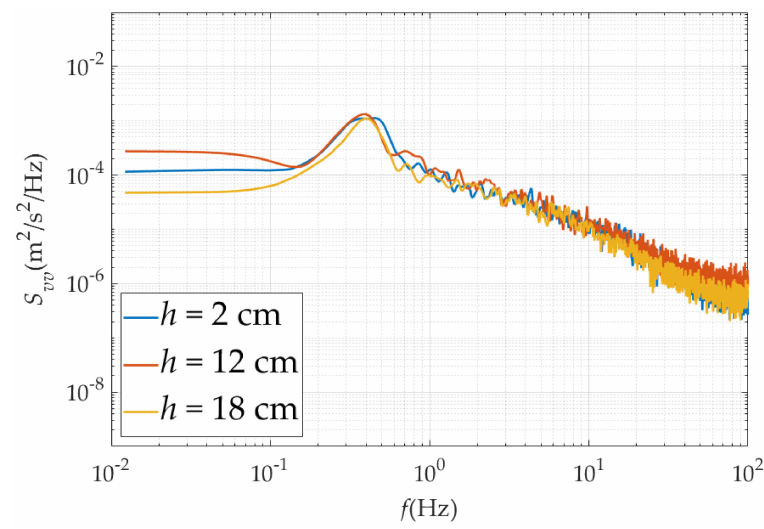
Figure 7. PSD of different depths at the centerline of the 45 ◦ section for Case